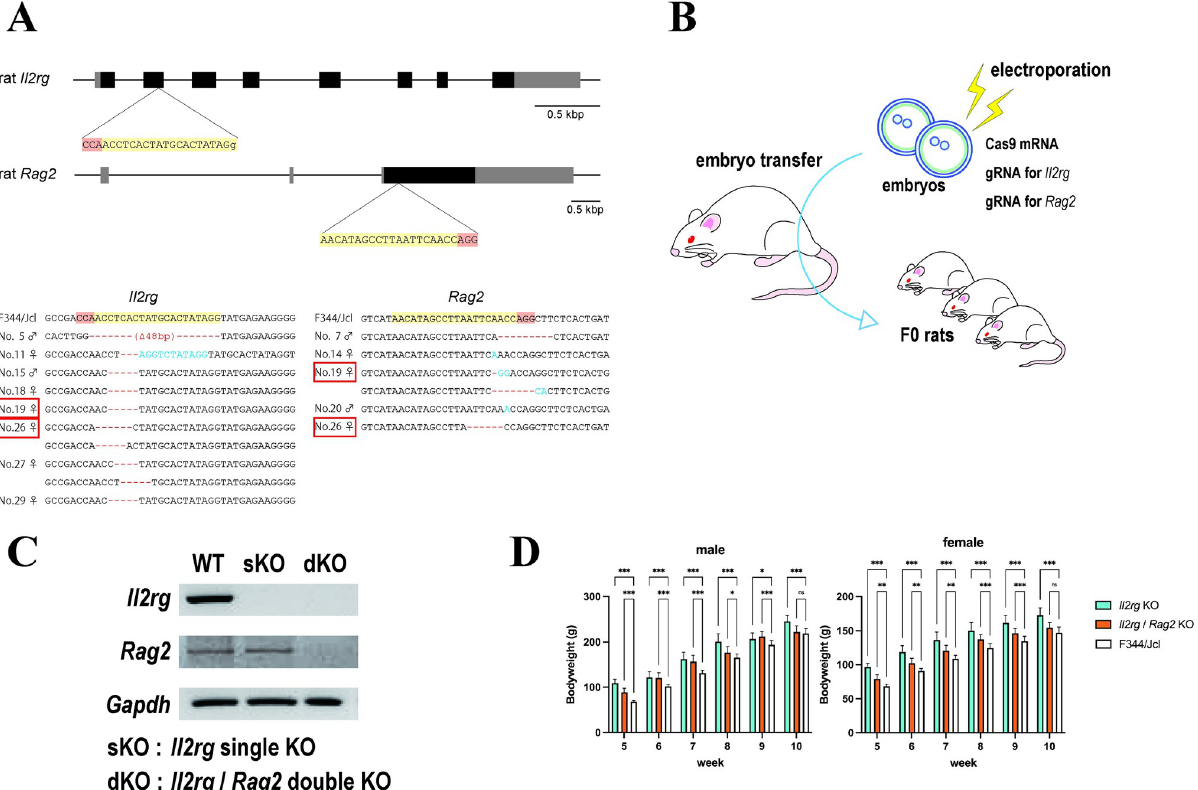
Fig 1. Knockout of the Il2rg and Rag2 genes. (A) Schematic diagram of the gene knockout strategy and targeted sequences of the mutant F0 progenies. Blocks indicate exon regions. Guide RNAs (gRNAs) targeted to exon 2 of Il2rg and exon 3 of Rag2 are highlighted in yellow; the protospacer adjacent motif (PAM) sequences are highlighted in pink. Targeted sequences of the F0 progenies are listed for comparison with the wild-type sequences. Short red lines indicate deletions and blue characters indicate insertions. Progenies that simultaneously carry mutations in both Il2rg and Rag2 are indicated with red boxes. (B) Schematic representation of the method used for CRISPR-based knockout experiments in rat embryos. (C) RT-PCR analyses of Il2rg and Rag2 from single-knockout (sKO) and double-knockout (dKO) rats (15-week-old) were conducted. Gapdh was used as the control. Here, images of different gels were partially cropped to facilitate display as a single figure. (D) Body weights of F344/Jcl wild-type, Il2rg -sKO, and Il2rg / Rag2 - dKO rats were measured weekly, beginning at the fifth week postpartum. The graphs show the body weights of male (left) and female (right) rats. For both sKO and dKO rats, six male and six female rats were assessed. The reference weight data of the F344/Jcl wild-type rats were provided by CLEA Japan, Inc. (Tokyo, Japan) (n = 20). sKO and dKO rats were sometimes significantly heavier than the wild-type rats, but no growth retardation was observed. Data are presented as means with standard deviations. Multiple comparisons of each group (sKO or dKO) versus F344/Jcl were conducted using Dunnett’s test. Asterisks or “ns” represent adjusted p -values: ns, 0.12; � , 0.033; �� , 0.002; ��� , <